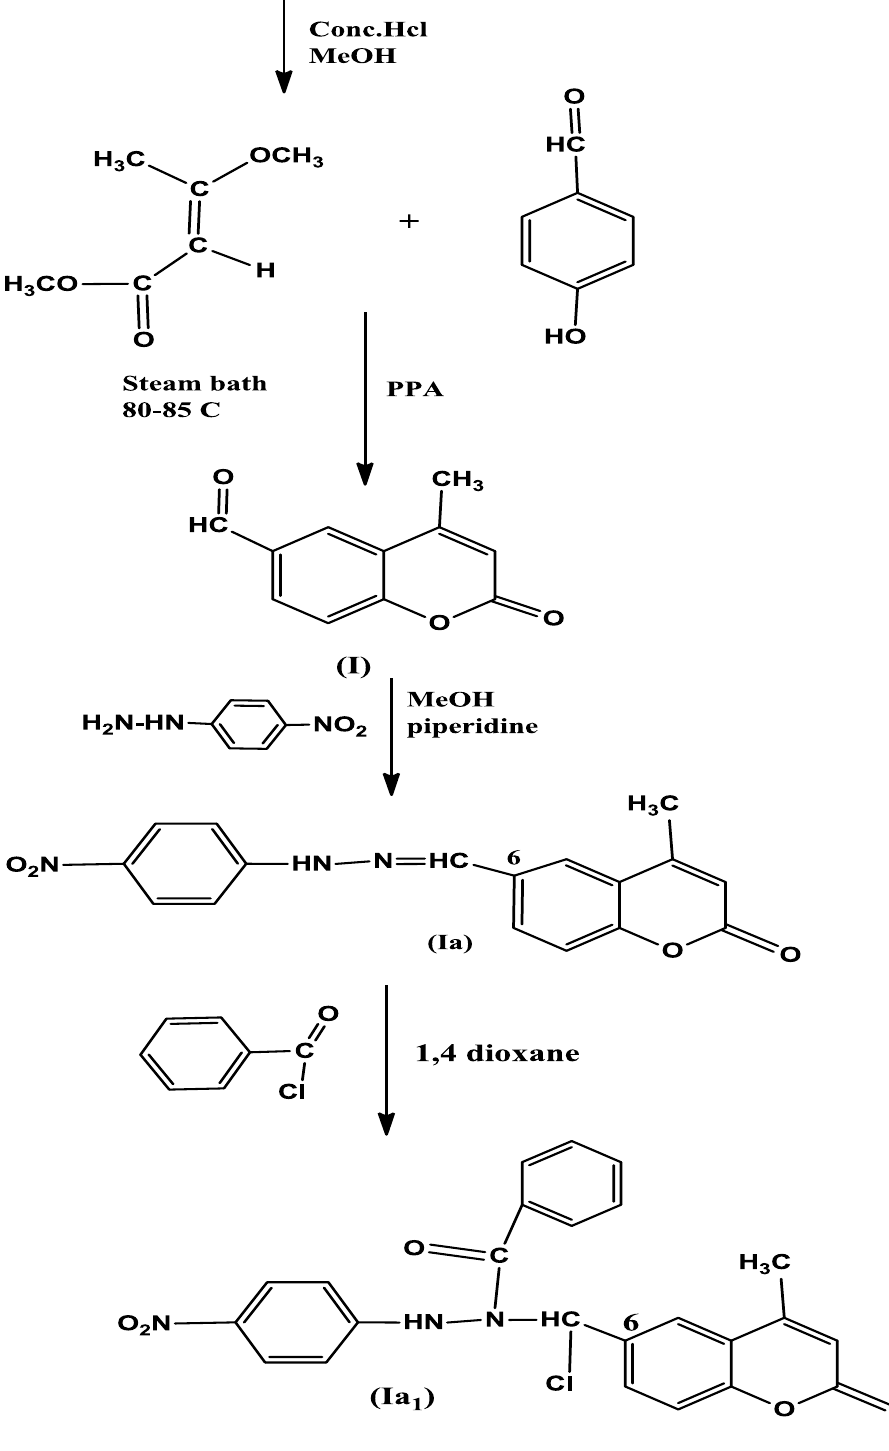
Scheme 1: pathway of synthesis of compound (Ia